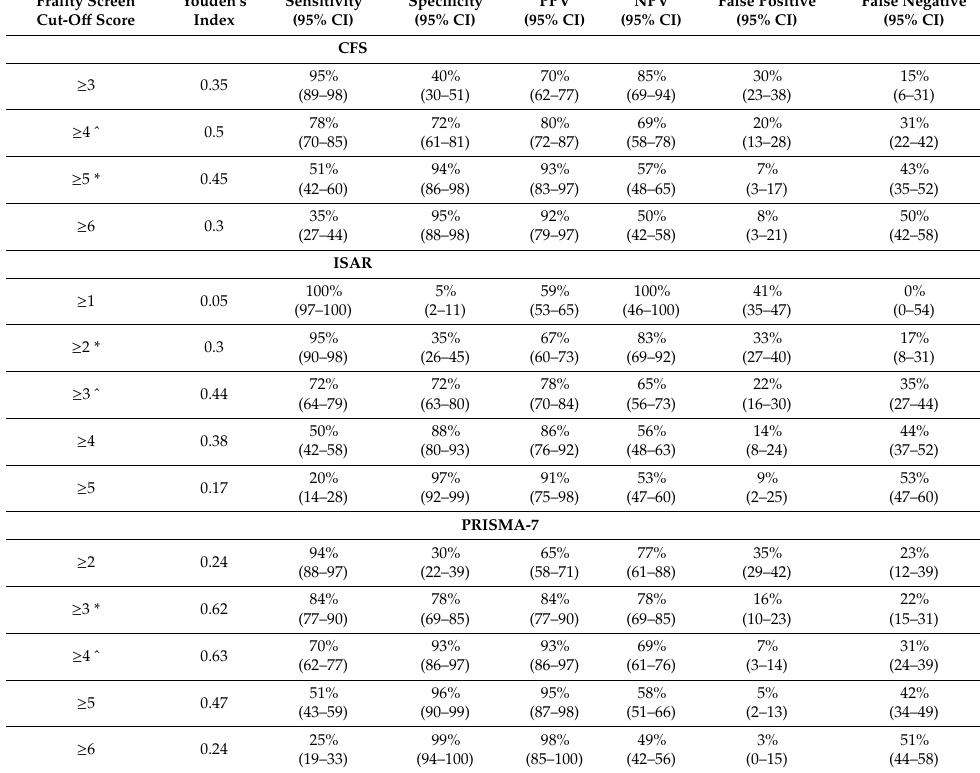
Table 3. Sensitivity, specificity, positive predictive value (PPV), and negative predictive value (NPV), with 95% confidence intervals (CI), for the Clinical Frailty Scale (CFS), Programme of Research to Integrate Services for the Maintenance of Autonomy 7 (PRISMA-7) tool, and the Identification of Seniors at Risk (ISAR) tool for frail and non-frail (based on the comprehensive geriatric assessment